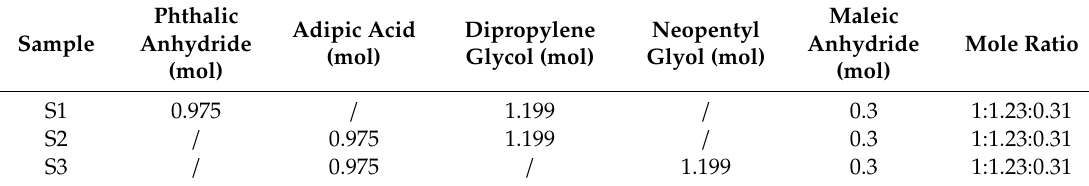
Table 1. Formulations of three types of S1, S2 and